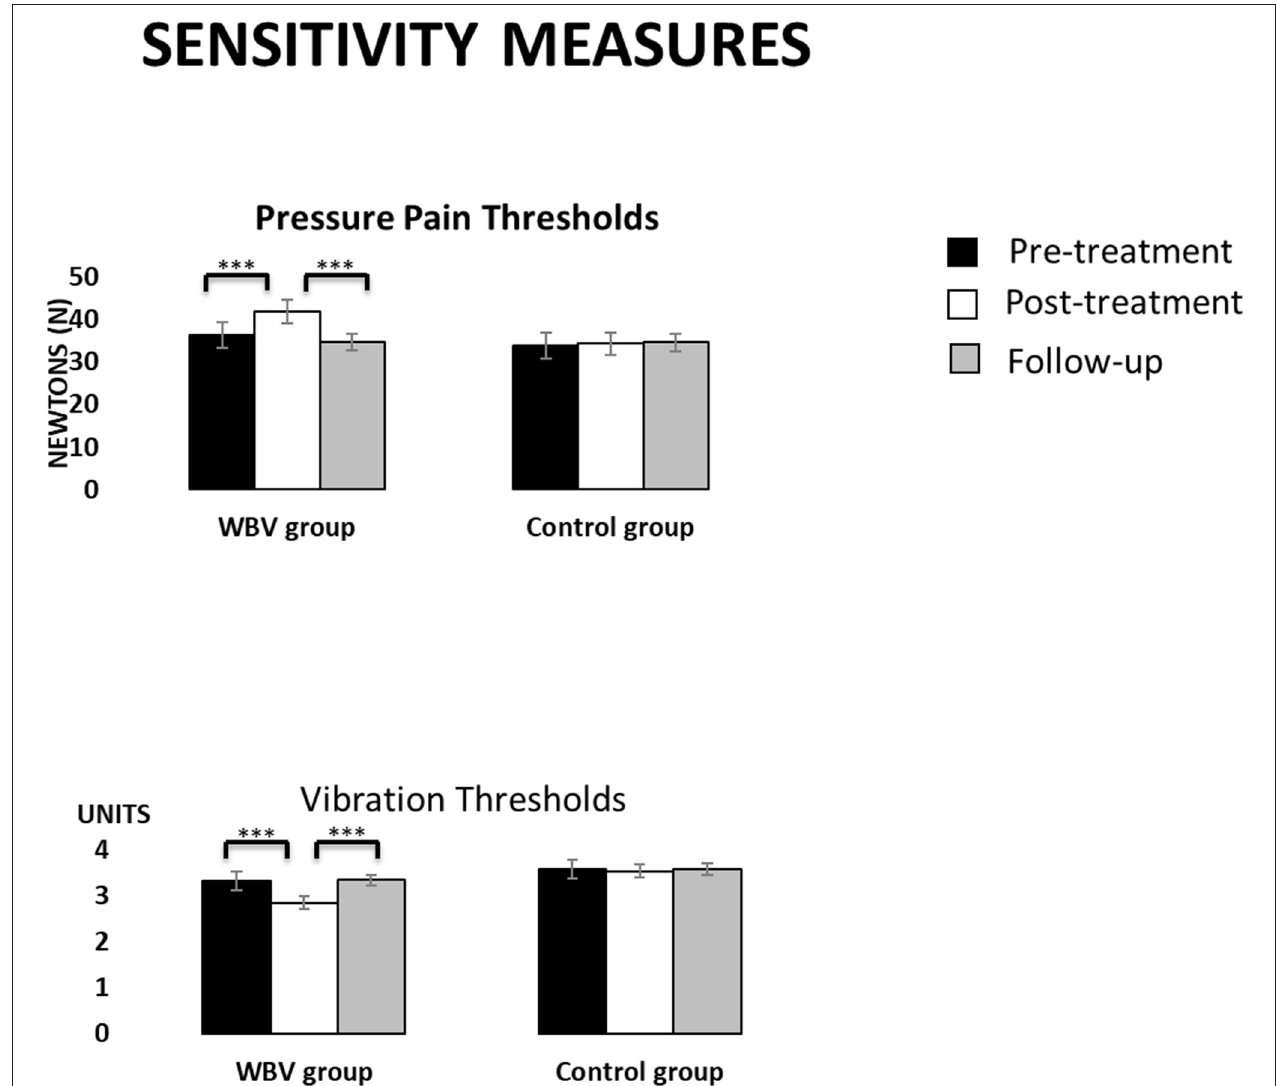
FIGURE 2 | Descriptive data (mean and TE) for the WBV group and the control group in sensitivity measures at the three assessment times. *** p < 0.001.